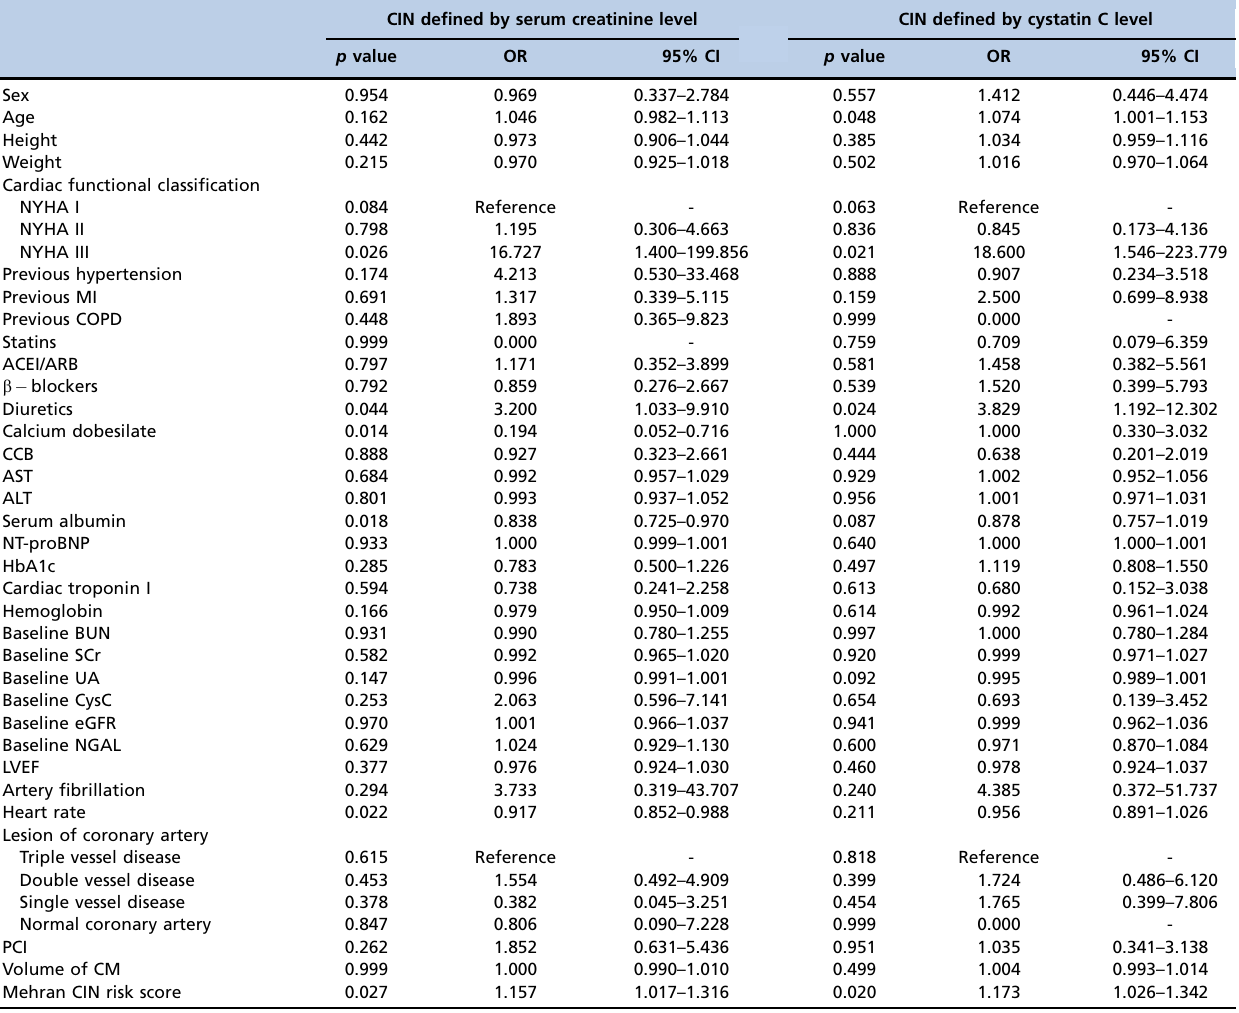
Table 4 - Univariate logistic regression analysis for the incidence of